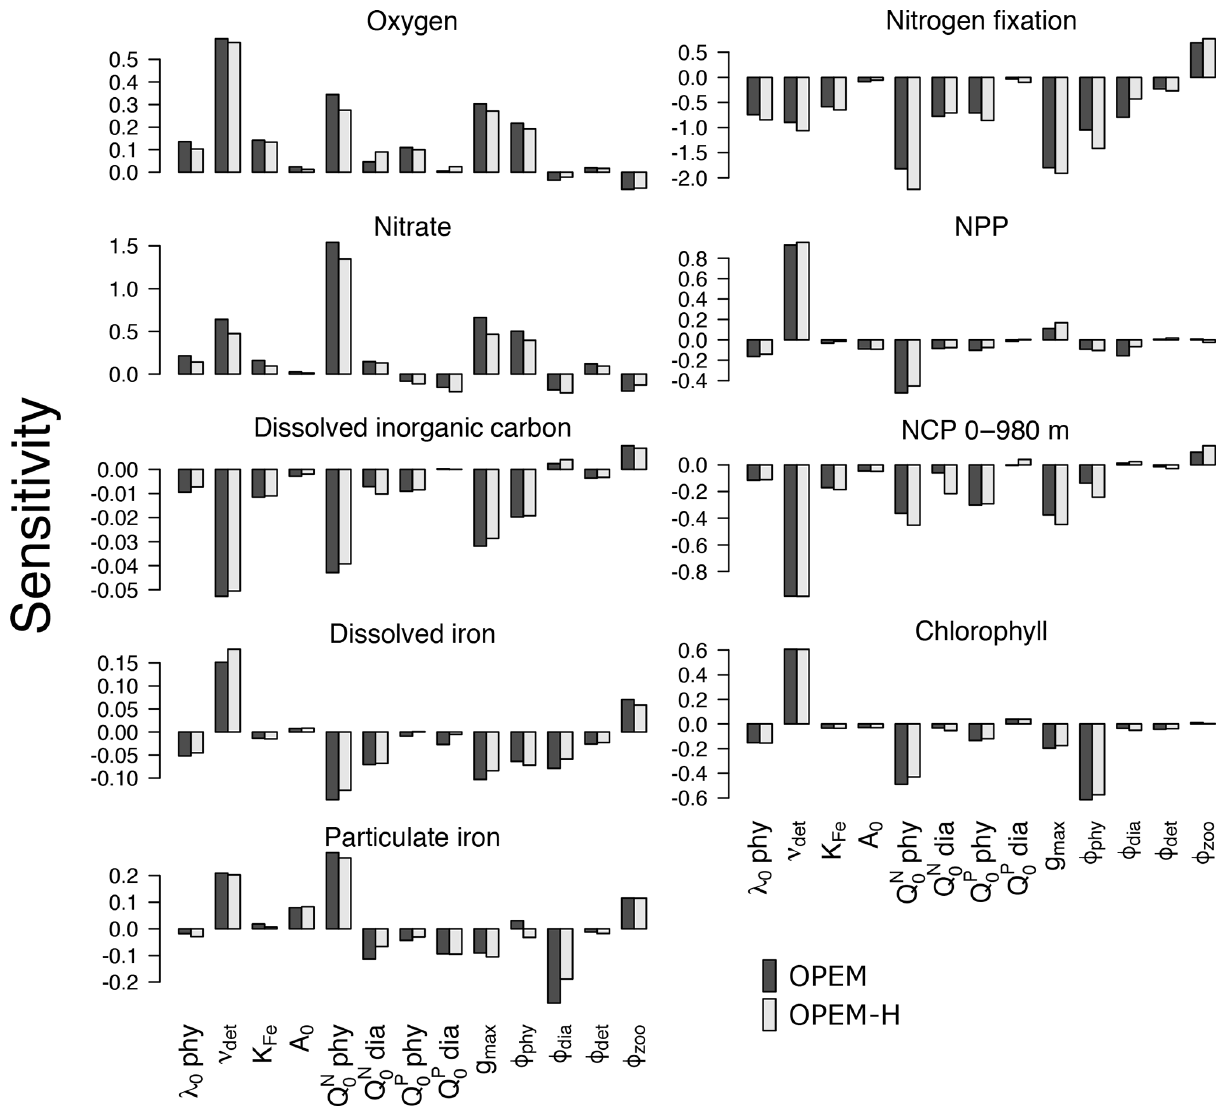
Figure 1. Sensitivities of globally averaged O 2 , NO − , dissolved inorganic carbon, dissolved iron, particulate iron, N 2 fixation, NPP, chloro- 3 phyll, and NCP integrated from 0 to 980m to individual model parameters, computed according to Eq. (3). Note the different y -axis ranges in the different